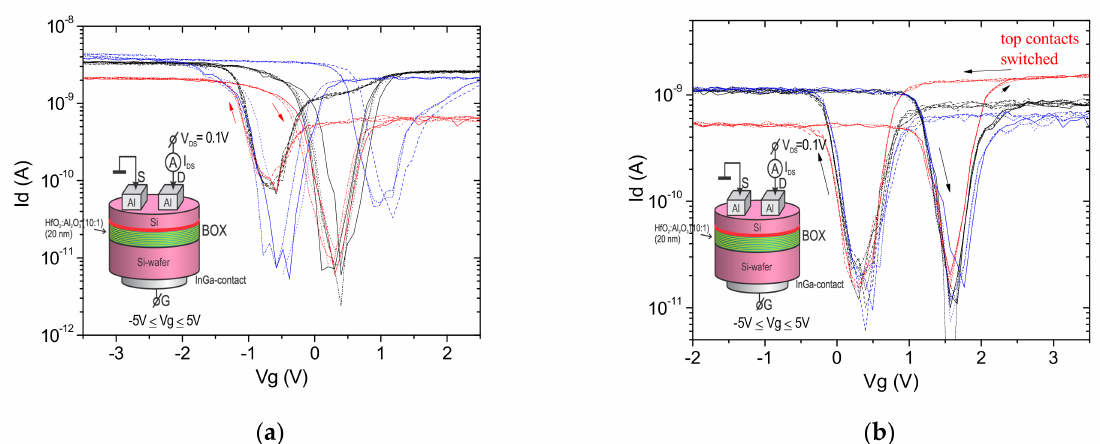
Figure 9. Ferroelectric hysteresis at the transfer characteristics of pseudo-MOSFET on the np-SIS mesastructure with the 500 nm n-Si/ 20 nm built-in insulator BOX nanolaminate HfO 2 :Al 2 O 3 (10:1)/n-Si substrate: ( a ) after the RTA at 800 ◦ C and ( b ) after the RTA at 900 ◦ C for three different sweep rates: 0.4 V/s (black), 0.12 V/s (red) and 0.04 V/s (blue) and three sweep cycles (solid, dot and dash-dot